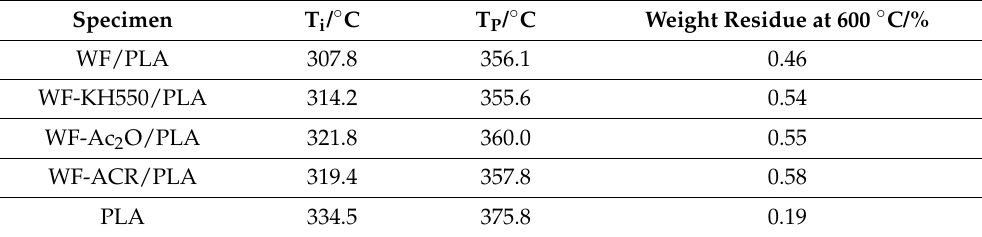
Figure 4. ( a ) TGA curves and ( b ) DTG curves for the samples indicated at 20 K/min in a nitrogen atmosphere. Table 1. Thermal decomposition parameters for various composites in a nitrogen atmosphere.